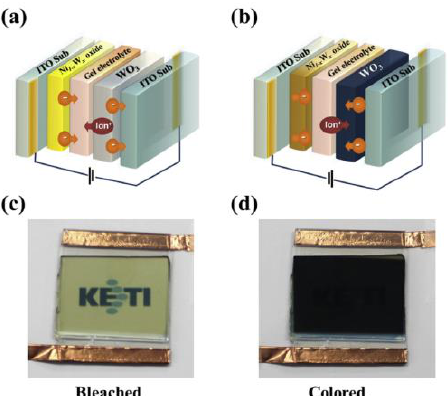
Figure 2. Schematic and optical images of an EC device embodying a gel electrolyte and two complementary inorganic anodic / cathodic materials. The bleached and colored states are reported. Device scheme in bleached ( a ) and colored ( b ) conditions. Device pictures reporting bleached ( c ) and colored ( d ) conditions. Reprinted from “Investigation of all-solid-state electrochromic devices with durability enhanced tungsten-doped nickel oxide as a counter electrode”, Journal of Alloys and Compounds 815 (2020) 152399, Copyright (2020), with permission from Elsevier.